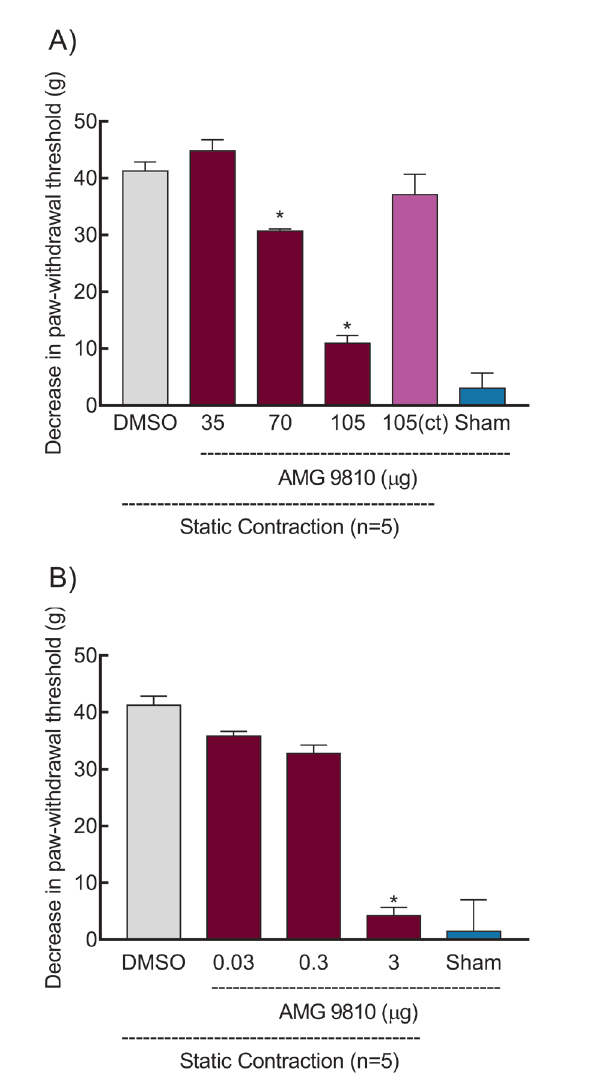
FIGURE 1 - Involvement of TRPV1 receptors in mechanical muscle hyperalgesia induced by static